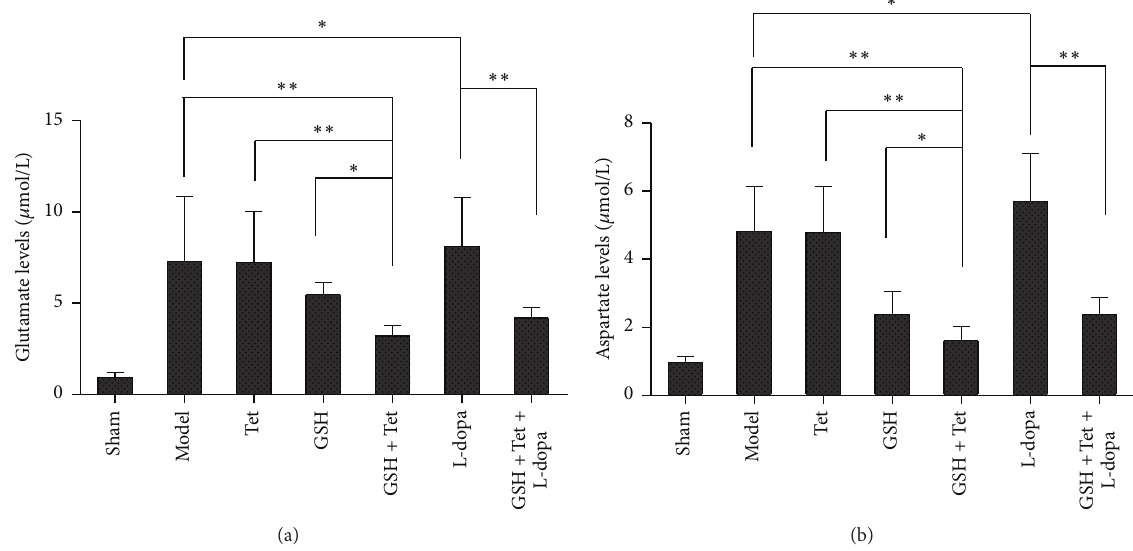
Figure5:Changesinglutamate(a)andaspartate(b)inthestriatumofthelesionsidesaftercorrespondingdrugadministration.Barsrepresent mean ± standard deviation (SD) for six animals per group. ∗ 𝑝 < 0.05 , ∗∗ 𝑝 < 0.01 comparison among different groups after drug